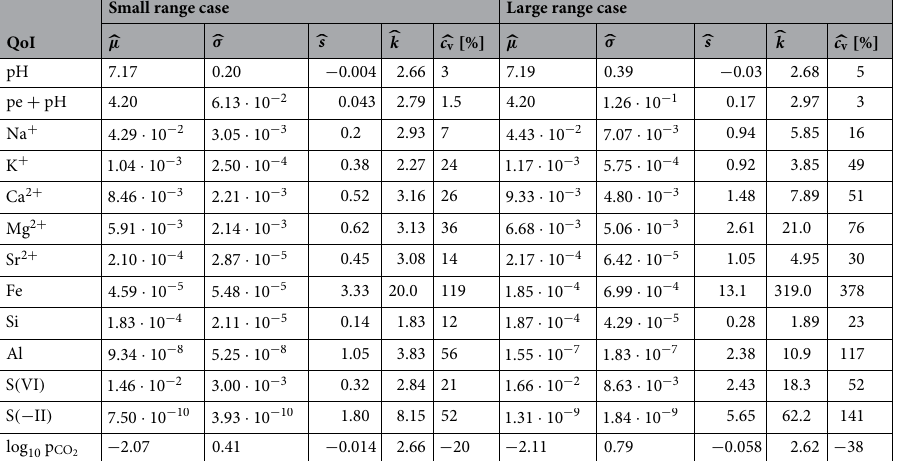
Marginal distributions. Small range case results exhibited three types of empirical marginal distribution pH (not shown), Na + , K + , Ca 2 + , Mg 2 + , Sr 2 + , S ( VI ) , and profiles (Fig. 2): bell-shaped distributions for pH , pe + log p CO II ) , and Fe ; and a piecewise linear distribution for Si . Large ; right-skewed distributions for Al , S ( 10 2 − range case results led to a flattening of the distributions (except for Fe ), which was coherent with variances increase. The shape of a distribution can be described by skewness s and kurtosis k that are defined as the third and fourth standardized moments, respectively. The empirical estimators of s and k , indicated in Table 4, are